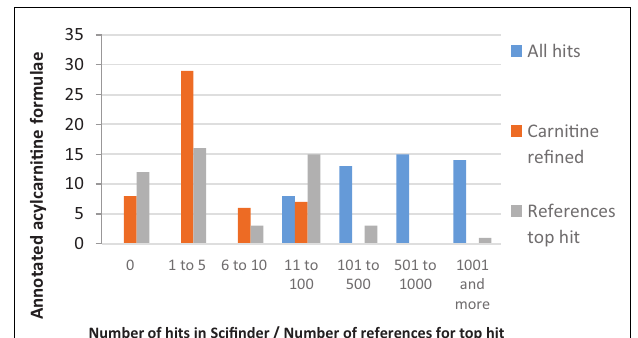
FIGURE 7 | Combined bar plot of the number of annotated acylcarnitine formulae for: (i) “All hits,”i.e., the number of Scifinder hits for elemental formulas (EF) of the 50 annotated acylcarnitine formulae, (ii) “Carnitine refined hits,” i.e., the number of Scifinder hits with the refinement of a carnitine substructure, and (iii) “References top hit,” i.e., the number of references to the most cited acylcarnitine (top hit)